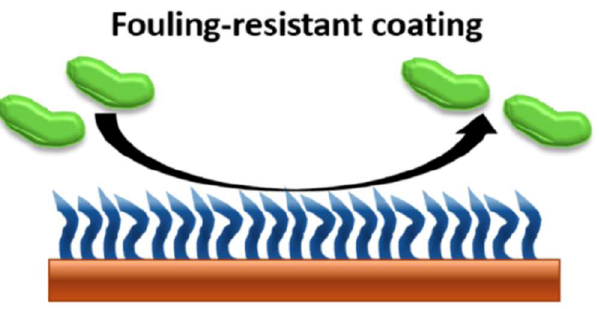
Figure 1. Schematic representing an antifouling coating. Reprinted with permission from Ref. [14] Copyright 2021 American Chemical Society.